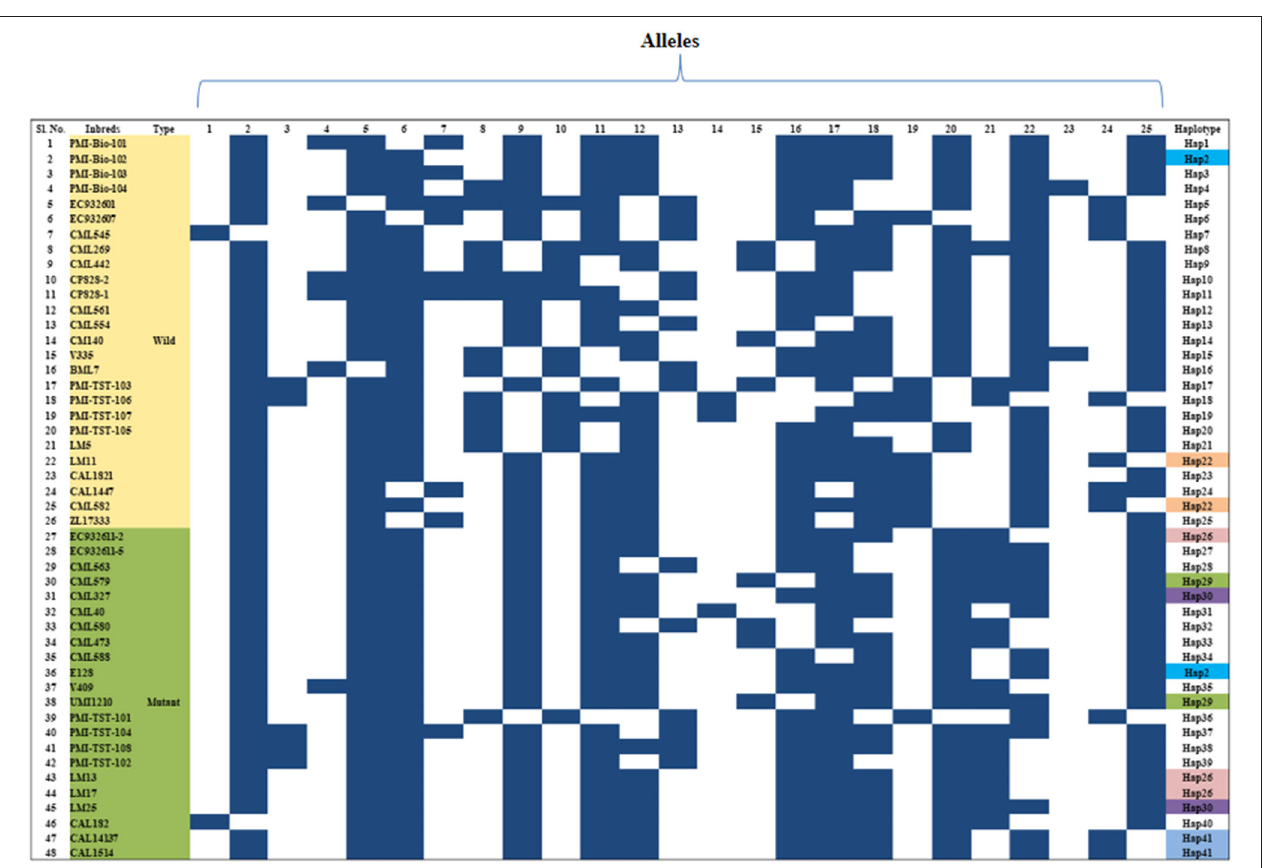
FIGURE 3 | Haplotypes of Zmfatb gene using gene-based InDel markers; each row indicates the presence or absence of allele, whereas the column represents the allele for a given marker in diverse inbreds; Black box, presence of DNA band; White box, absence of DNA band.